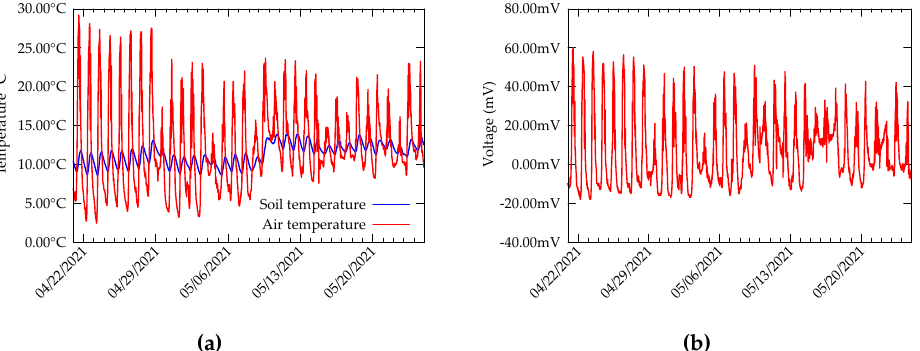
Figure 3. Data from test bed deployed in the CDE campus of University of Antwerp during April 2021. ( a ) Soil temperature (TEG cold side) and air temperature (TEG hot side). ( b ) TEG open circuit